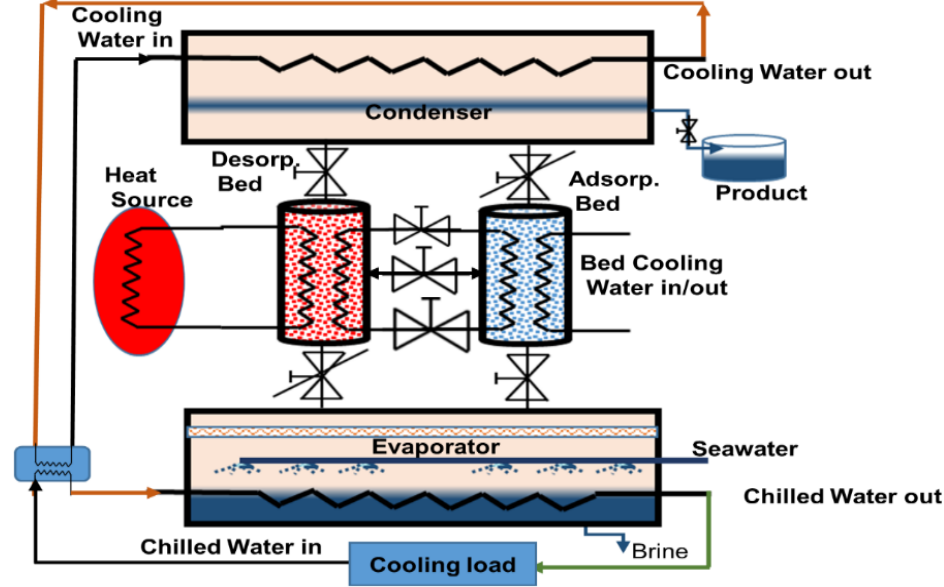
Figure 12. Advanced ADD with mass and heat recovery configuration.